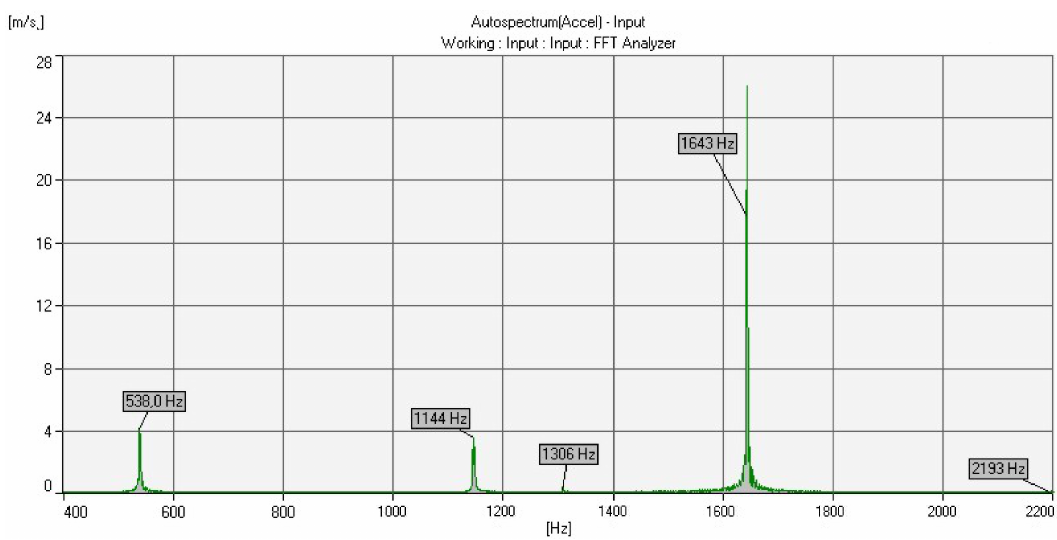
Figure 14. Experimental frequency analysis results—bell bronze.